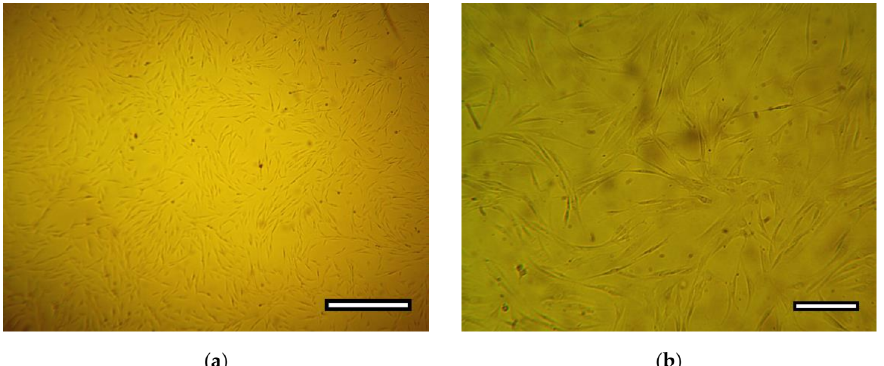
Figure 5. ADSC after 48 h of cultivation. Phase contrast: ( a ) objective lens × 4, scale bar—800 µ m; ( b ) objective lens × 10, scale bar—200 µ m.